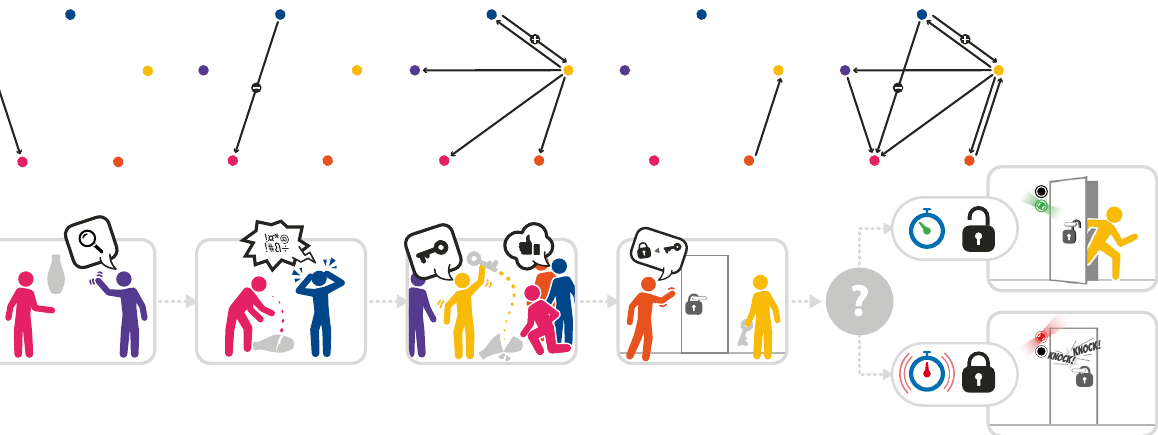
Figure 1. The complex and diverse dimensions of social interactions in escape rooms. We collect the social interactions of teams, who must collaborate in the non-routine environment of escape rooms to successfully solve tasks and thereby exit the room within an hour. Interactions are represented as temporal networks, which capture skeletal structure of communication between team members. Each interaction is directed, can be emotionally neutral or charged (either positively or negatively), addressed to a particular person (pairwise) or to a wider group. *This figure is produced by Szabolcs